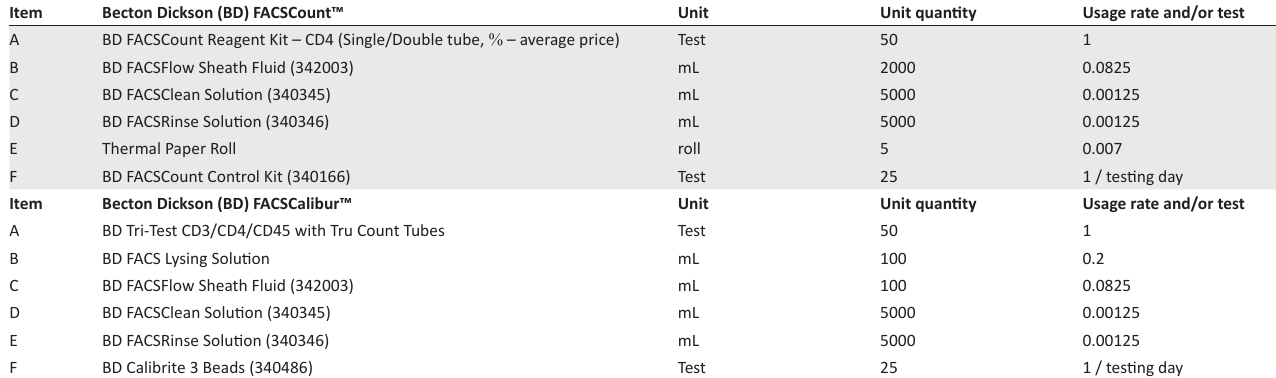
TABLE 1: CD4 count platform reagents and usage rates. Item Becton Dickson (BD)